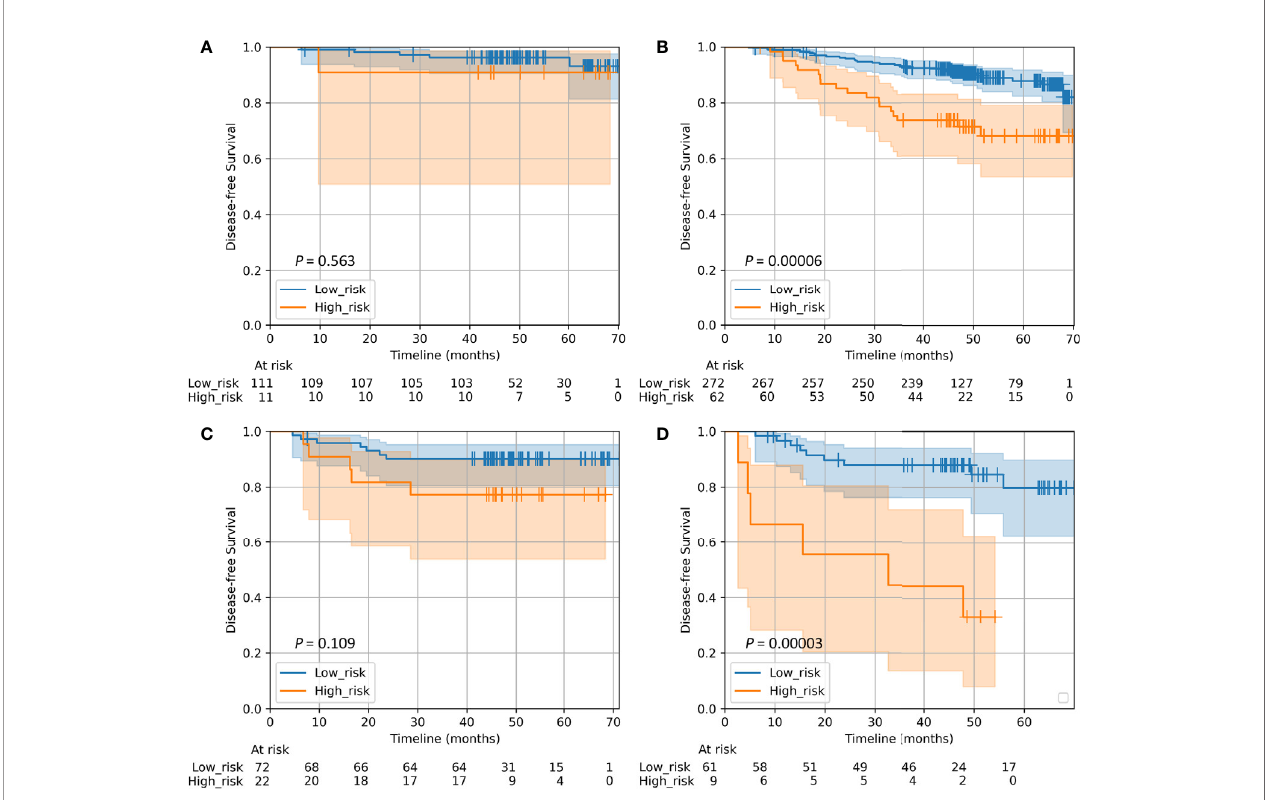
FIGURE 2 | Kaplan – Meier survival curves of DFS according to the Rad-score classi fi er in subgroups within molecular subtypes of patients with invasive breast cancer in the whole cohort. (A) Luminal A (n = 122). (B) Luminal B (n = 334). (C) HER2-enriched (n = 94). (D) Triple-negative (n = 70). We calculated P values using the log-rank test. DFS, disease-free survival; Rad-score, radiomics score.